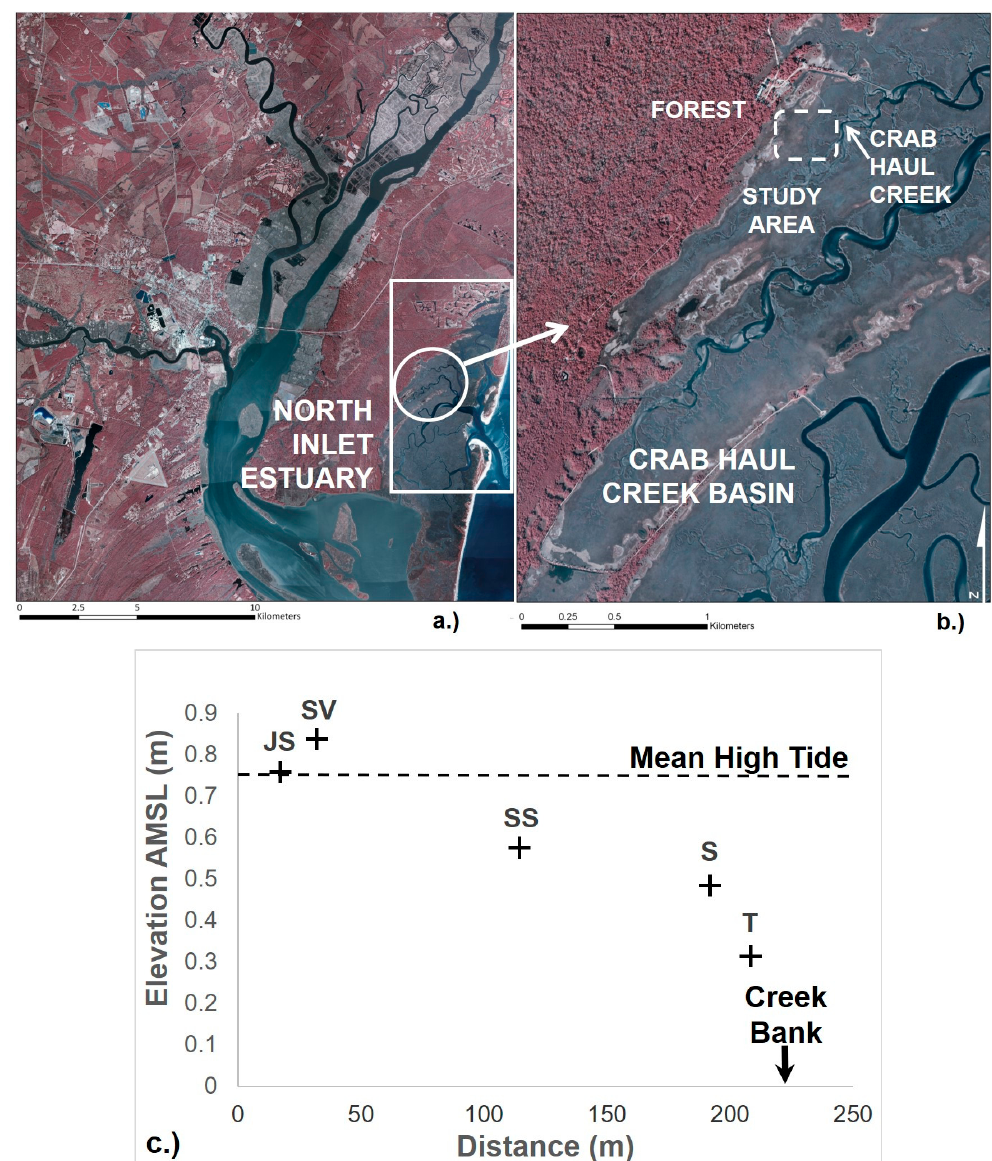
Figure 1. ( a ) Color (false ‐ color) infrared (CIR) aerial photograph of North Inlet Estuary showing Crab Haul Creek Basin (circled area); ( b ) CIR aerial photograph of Crab Haul Creek Basin showing study area, including forest edge and Crab Haul Creek (original CIR image from www.northinlet.sc.edu); ( c ) Vegetation zone elevation differences above mean sea level (AMSL) and distance of each sampling location from the forest edge. Vegetation zone designations: Juncus roemerianus stand (JS); Salicornia virginica (SV); mixed plant zone of co ‐ occurring S. virginica and short form Spartina alterniflora (SS); short form S. alterniflora (S); and tall form S. alterniflora (T). This is an amendment of an original image that was adapted with permission from reference [27]. Copyright 2011 Springer.